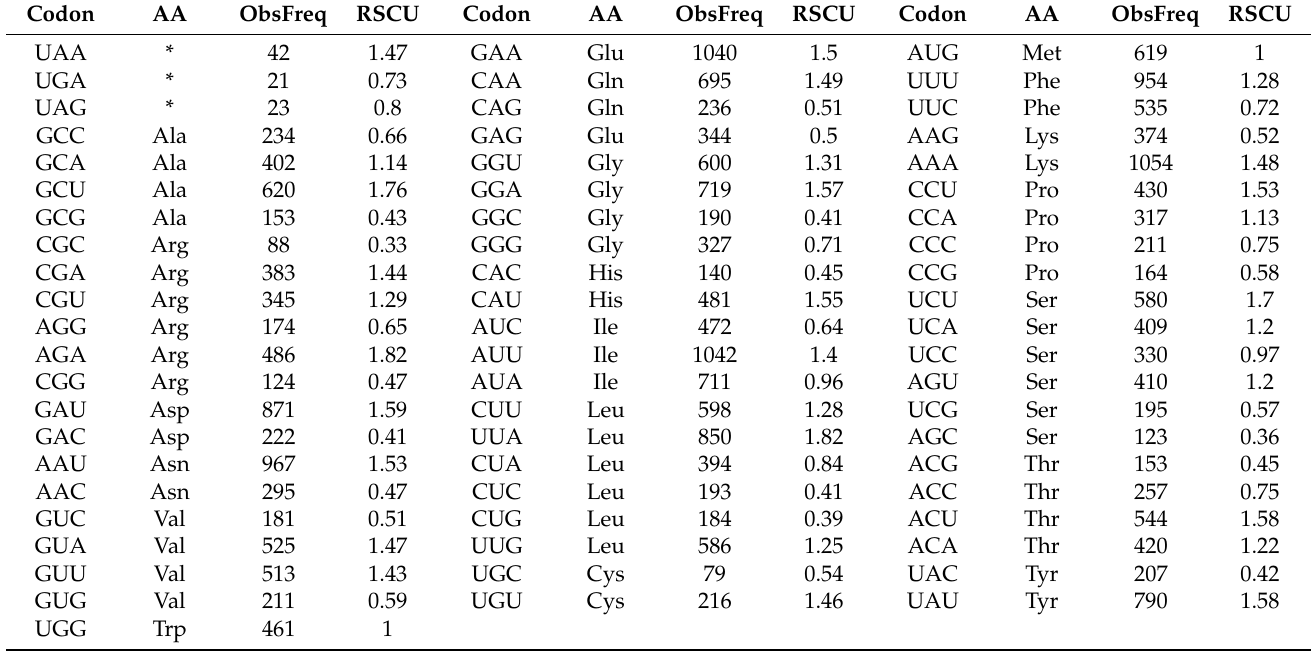
Table 3. Relative synonymous codon usage (RSCU) for protein-coding genes in D. oligodontus